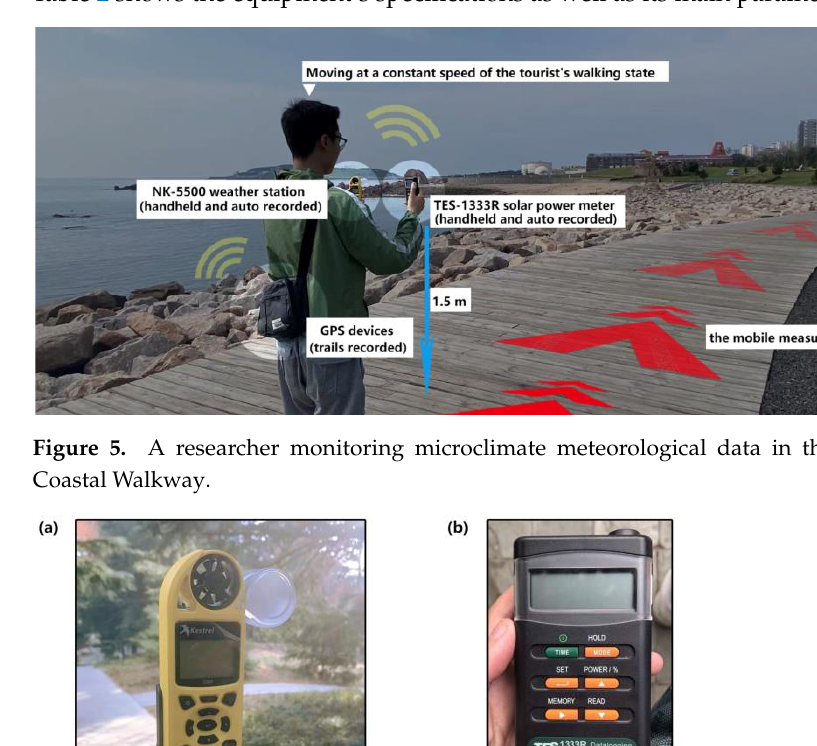
Figure 5. A researcher monitoring microclimate meteorological data in the Laoshan District Coastal Walkway.